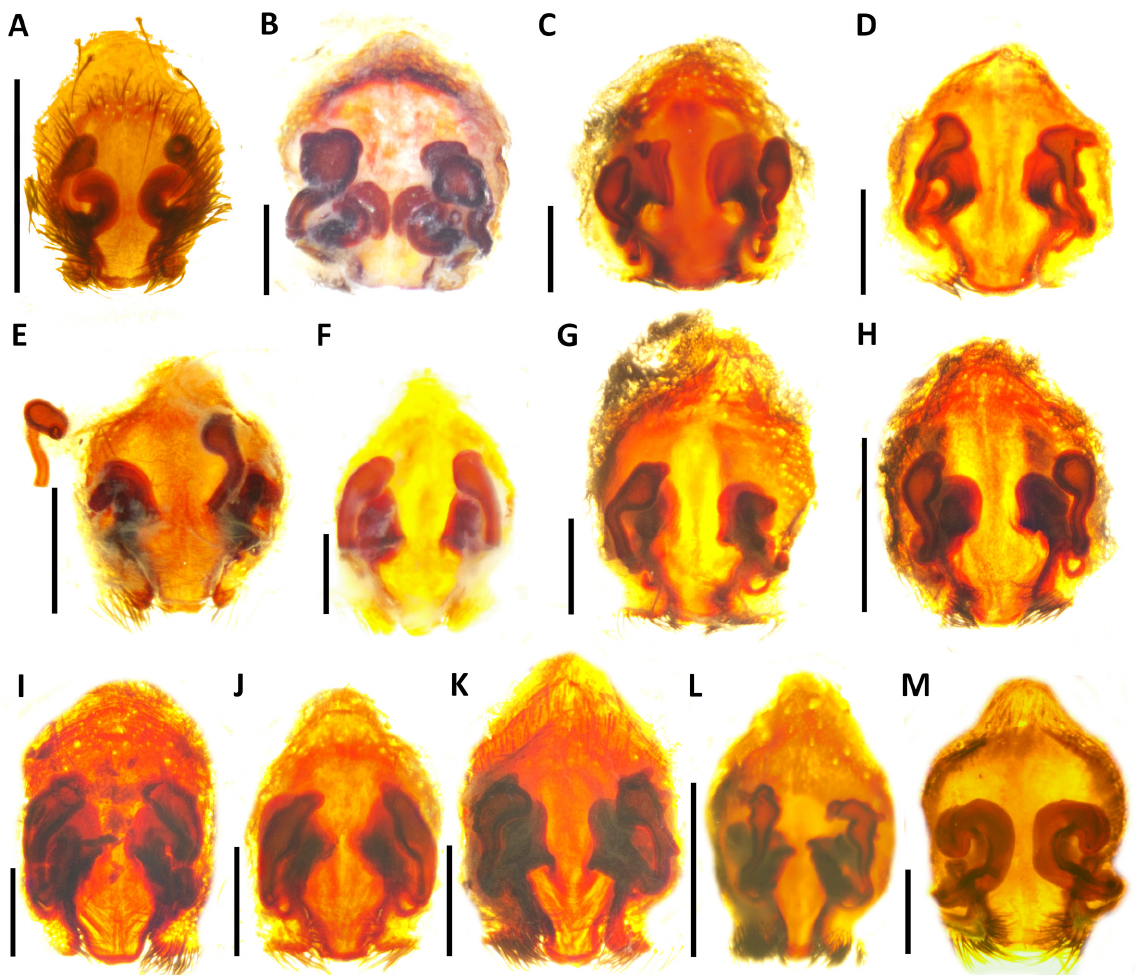
Fig. 10. Epigynes, dorsal view. A . Lycosa sp. (HUJ INV-AR20573). B . Lycosa hyraculus sp. nov., paratype (HUJ INV-AR20817). C–L . Lycosa piochardi Simon, 1876 (HUJ INV-AR20607). D . HUJ INV-AR20912. E . HUJ INV-AR20671. F . SMFD2184. G . HUJ INV-AR20963. H . HUJ INV-AR20709. I . HUJ INV-AR20897. J . HUJ INV-AR20530. K . HUJ INV-AR20860. L . HUJ INV-AR20758. M . Lycosa praegrandis C.L. Koch, 1836 (Veles, North Macedonia, 1 Jun. 2002; courtesy of Marjan Komnenov). Scale bars = 0.5 mm. Photos by I. Armiach